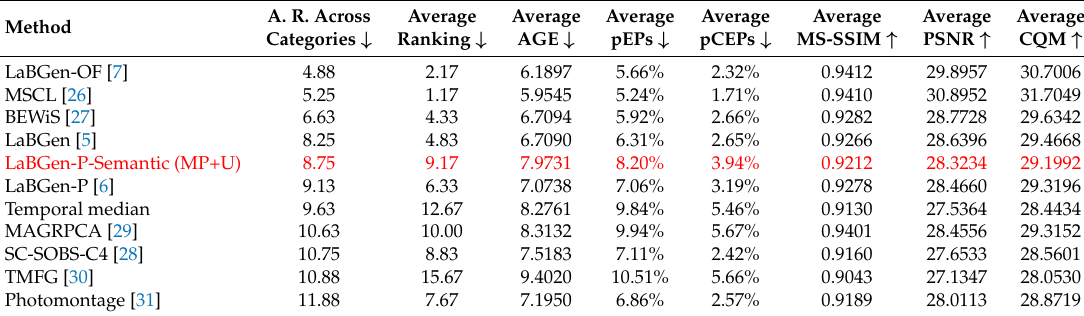
Table 5. Top 10 reported on the SBMnet website 6 May 2018 in which the performance achieved by LaBGen-P-Semantic with MP+U is inserted (in red). “A. R.” stands for average ranking.